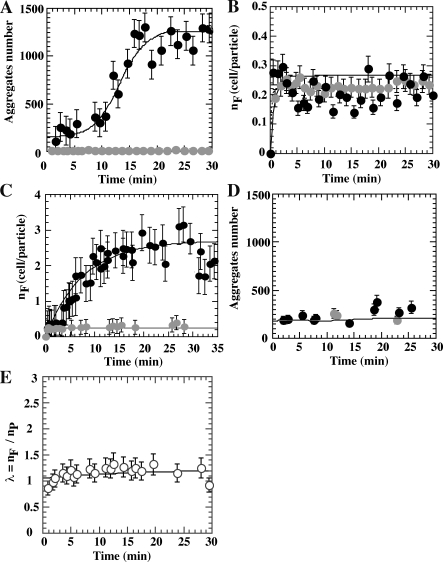
Aggregation and Surface Colonization Kinetics of Cells Expressing Different Cell Surface AdhesinsAg43 (A and B); F-pili (C and D) were examined under the same conditions as in Figure 4. (black circles) corresponds to cells producing indicated surface adhesin and (gray circles) to cells not producing surface adhesin. (E) Cooperative index in time for F pili–expressing cell colonization of NH3
+ particles.